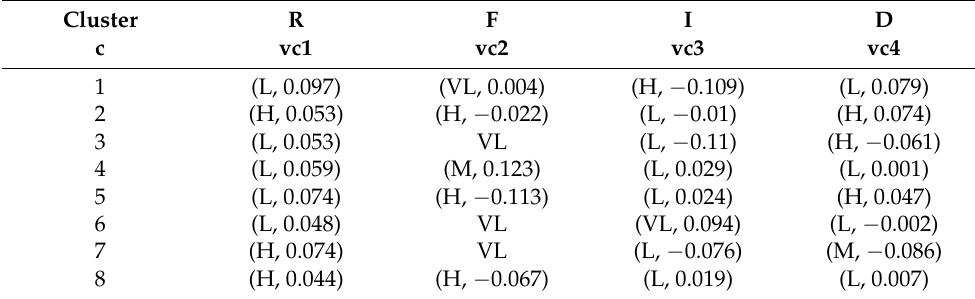
Table 12. Result of the k-Means Algorithm Expressed in the Two-Tuple Model.